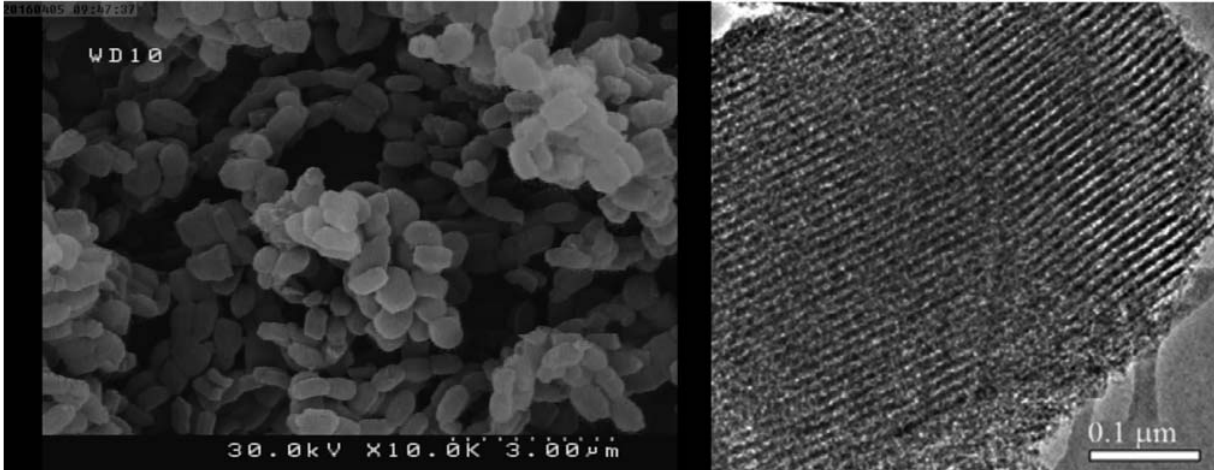
Figure 4. The SEM (left) and TEM (right) images of SBA-Pr-SO